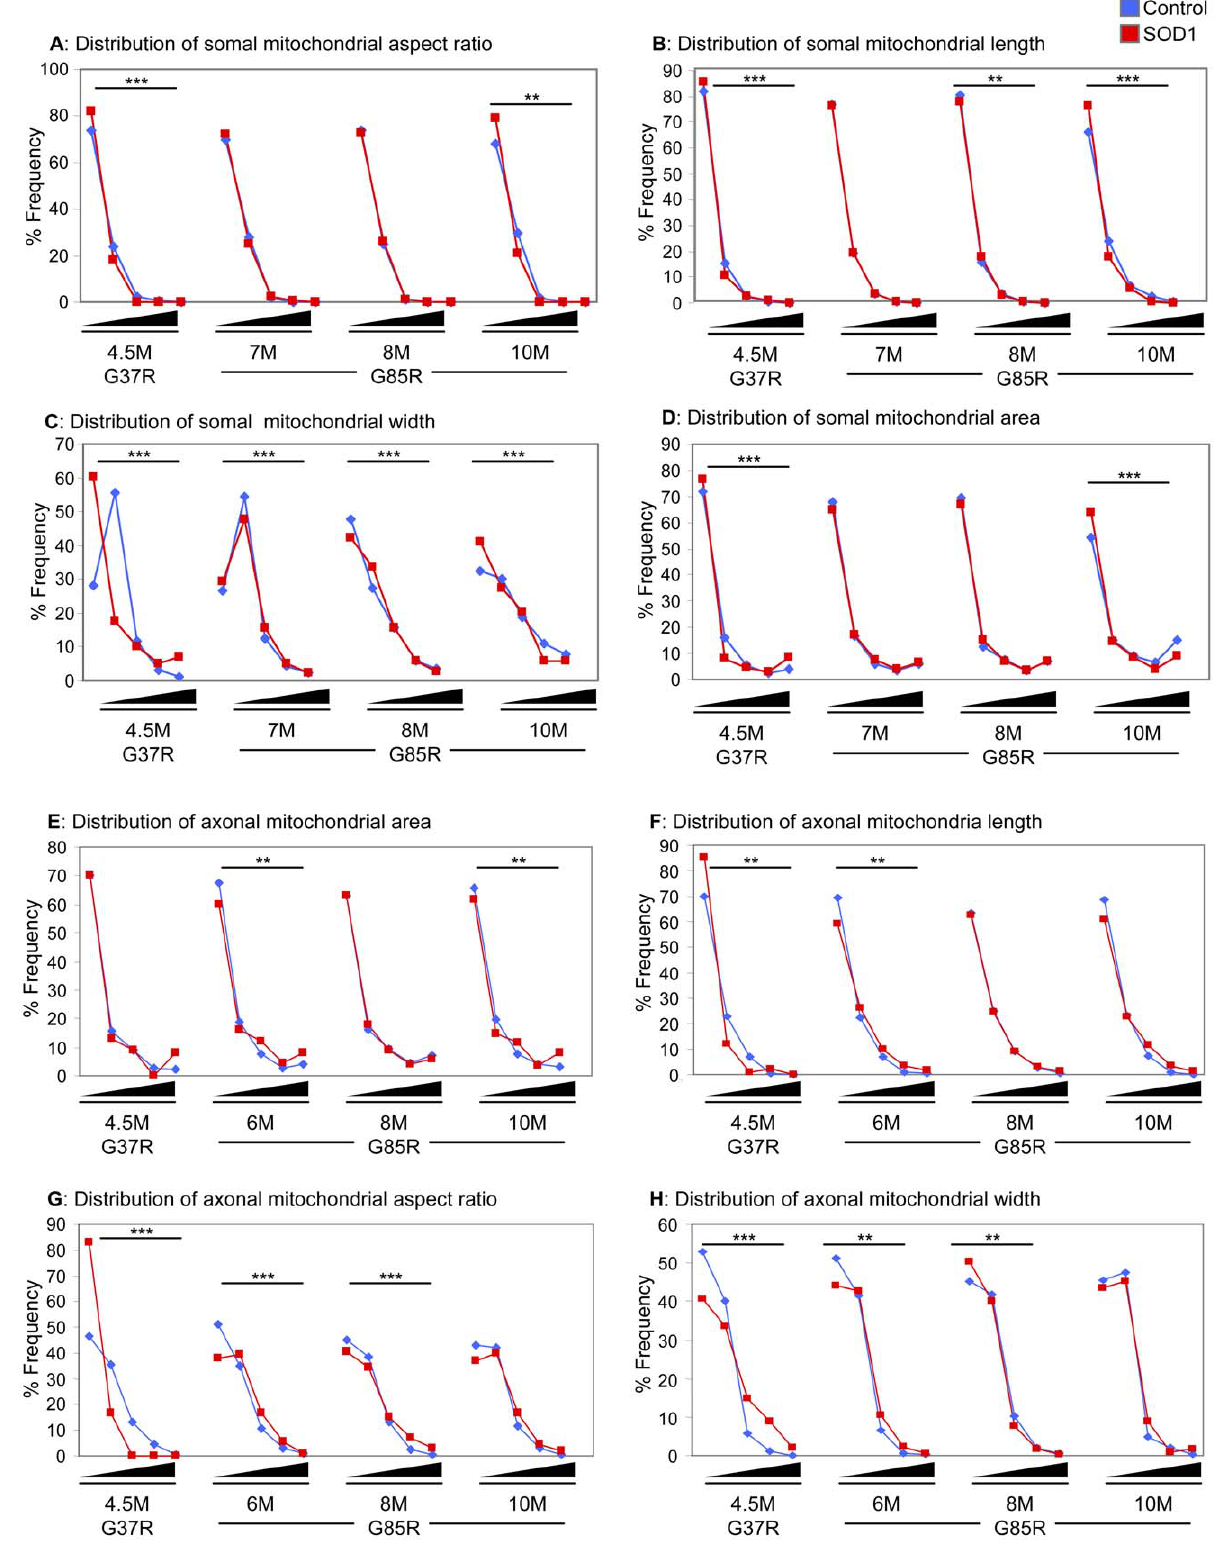
Figure 4. Distributions of mitochondrial morphology and distribution. Distributions in various morphological parameters of somal (A–D) and axonal (E–H) mitochondria. Bins for area (A,E) are 0–0.25, 0.26–0.50, 0.51–0.75, 0.76–1.0, and . 1.0 m m 2 . Bins for length (B,F) are 0–1, 1.01–2, 2.01–3, 3.01–4, and . 4 m m. Bins for aspect ratio (C,G) are 1–2, 2.01–4, 4.01–6, 6.01–8, and . 8. Bins for width (D,H) are 0–0.25, 0.26–0.50, 0.51–0.75, 0.76–1.0, and . 1.0 m m. Statistics have been calculated using Chi-square with Yates’ correction for continuity and significant differences in distributions are indicated: *, p , 0.05; **, p , 0.005; ***, p , 0.0005.